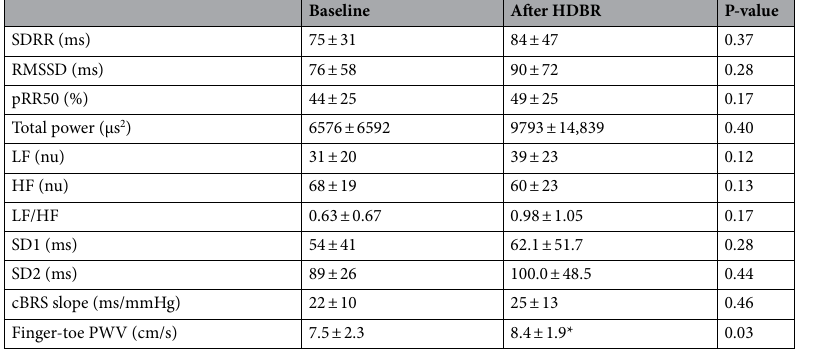
Table 2. Heart rate variability and cardiovagal baroreceptor sensitivity before and after HDBR. SDRR SD between RR intervals, RMSSD square root of the mean difference between adjacent beats, pRR50 proportion of RR interval differences greater than 50 ms divided by total beats, LF low frequency, HF high frequency, SD1 width of the Poincaré plot, SD2 length of the Poincaré plot, cBRS cardiovagal baroreceptor sensitivity, PWV pulse wave velocity. *Significant effect of HDBR. All values are mean ±